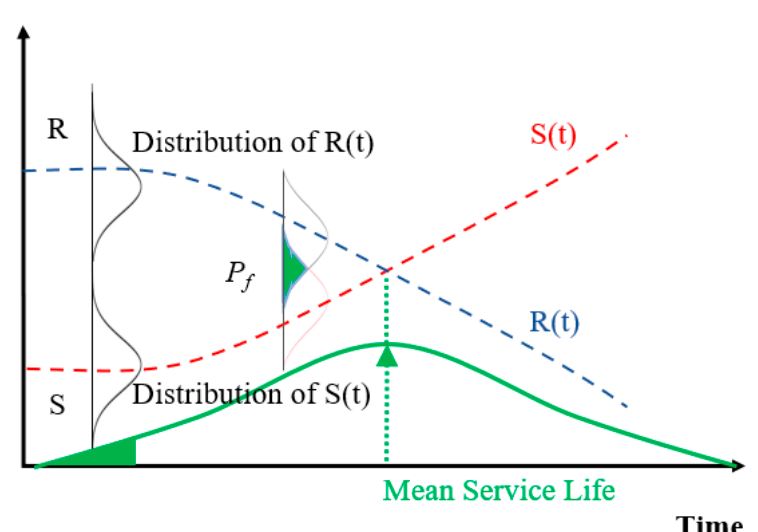
Figure 3. Durability design of probabilistic model with service life and lifetime concept.